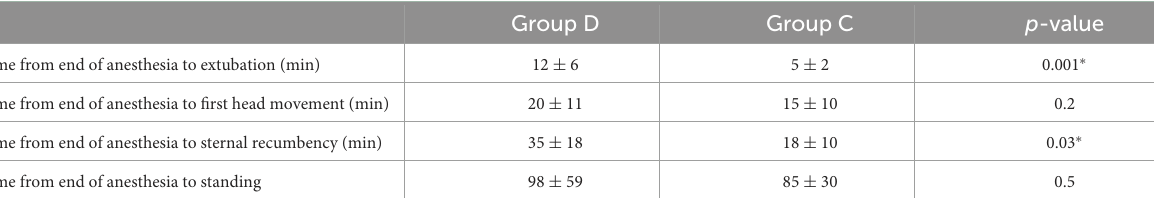
TABLE 3 Times of recovery between the